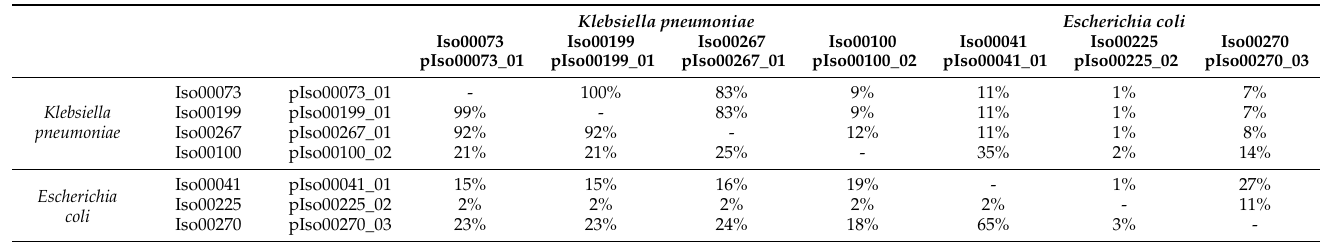
Table 2. Sequence homology as assessed by pairwise blastN analysis of bla CTX-M -gene containing plasmids/query